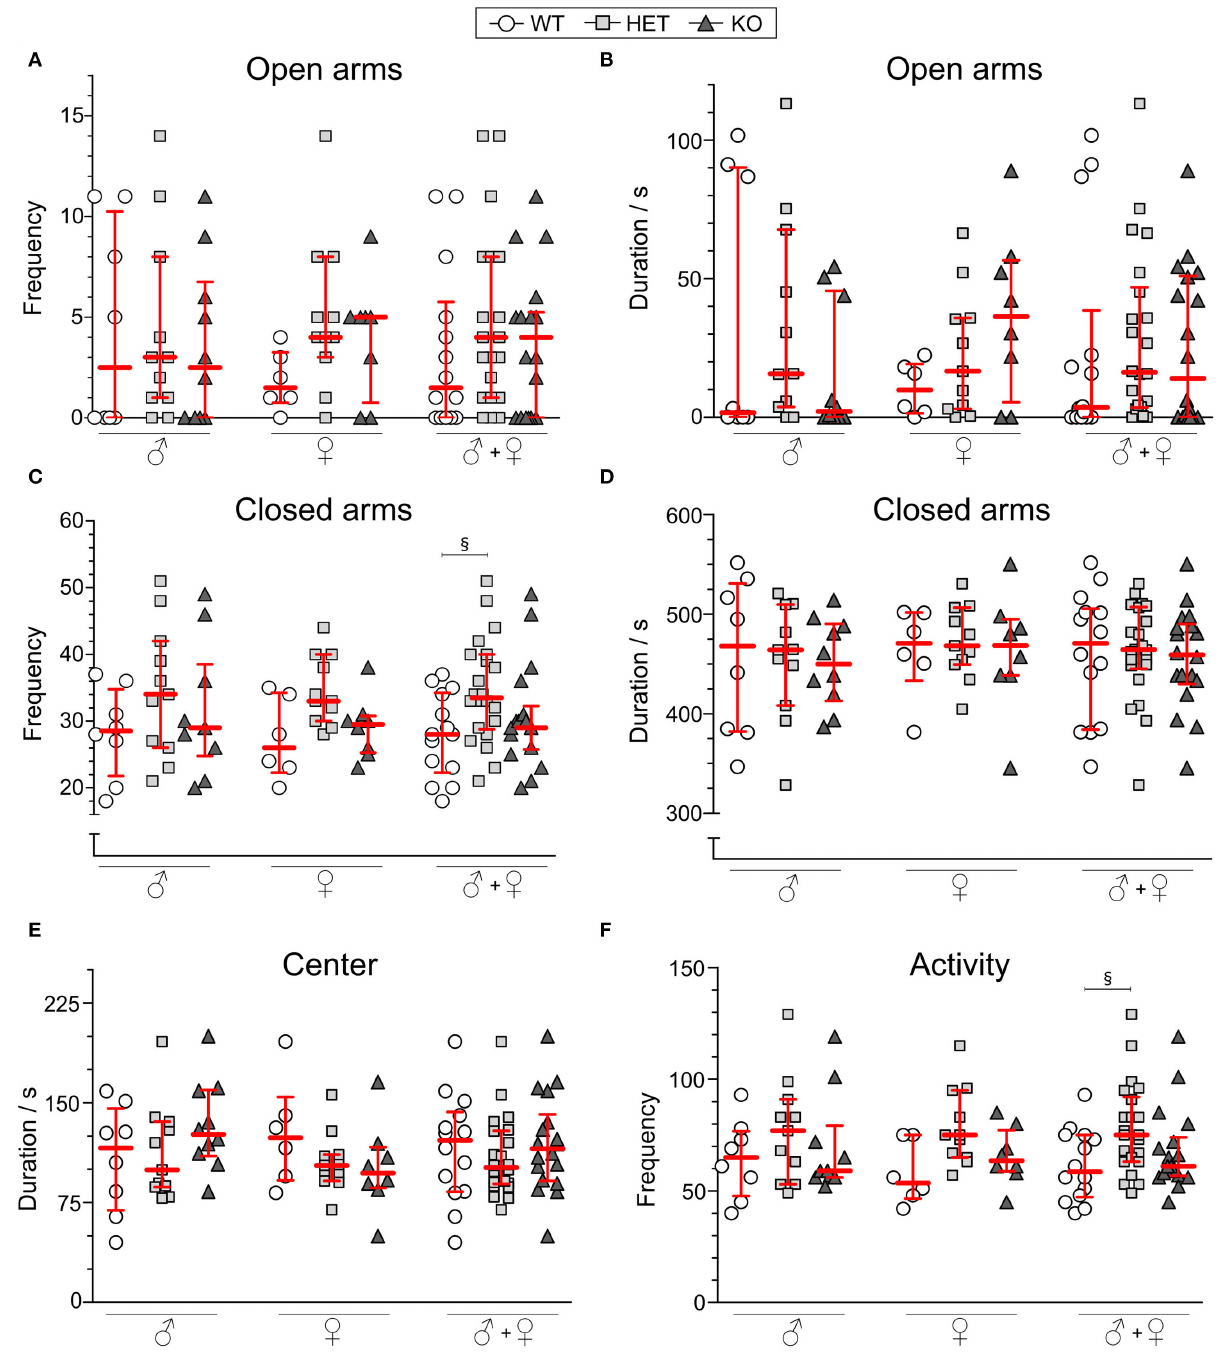
Frontiers in Behavioral Neuroscience |